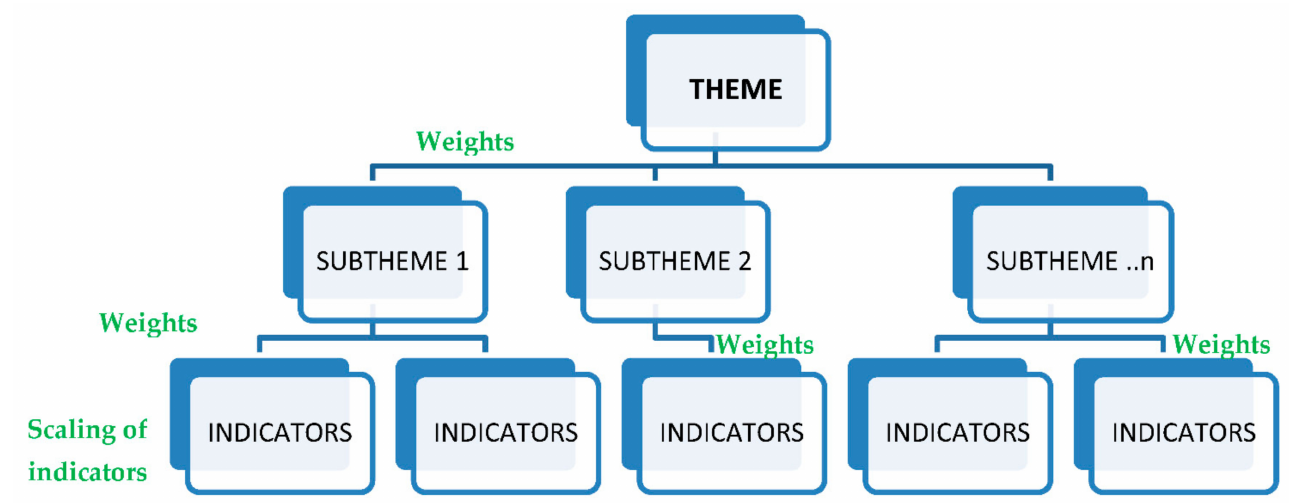
Figure 1. General methodological approach taken to aggregate indicators into subthemes and themes of the economic sustainability assessment. Source: Own elaboration. Table 1. Indicators, subthemes, and themes of economic sustainability and relevance (+) for three different types of pig